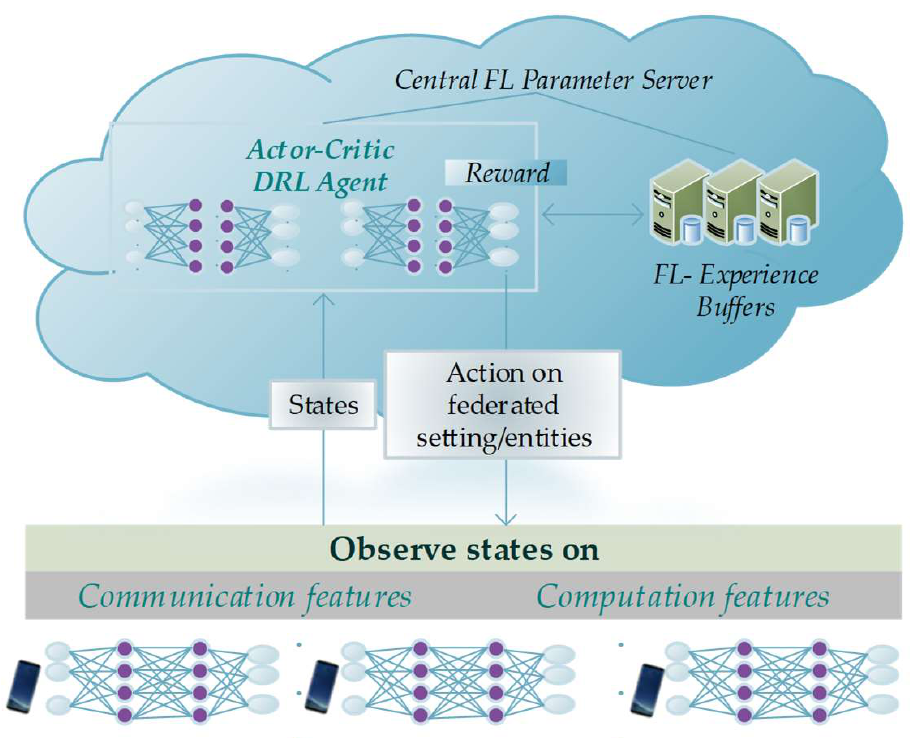
Figure 8. Experience-driven DRL (e.g., actor–critic) in setup environment of FL parameter server. The primary components of the proposed agent are described as follows.